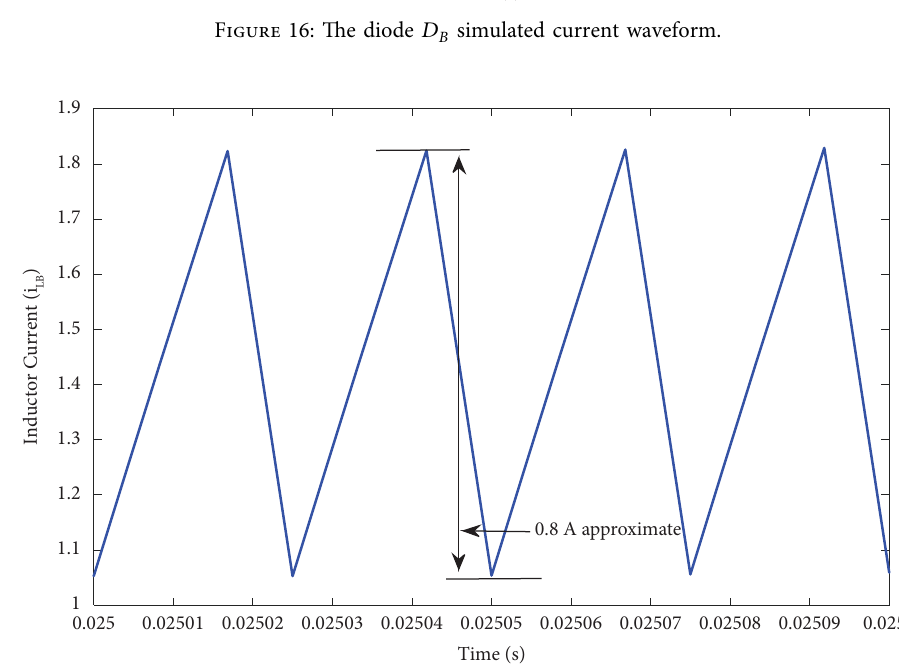
Figure 17: Te inductor L A simulated current